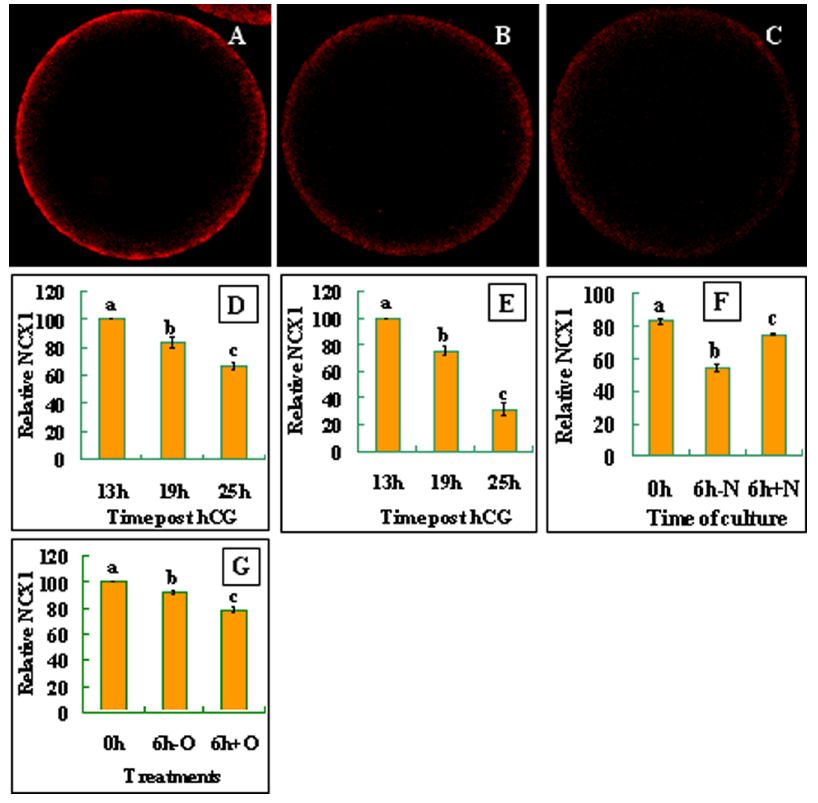
Figure 3. Distribution and quantification of NCX1 in mouse and rat oocytes. The micrographs are laser confocal images (equatorial sections) of oocytes with NCX1 pseudo-colored red. They show the cortical distribution of NCX1 in newly-ovulated mouse oocytes (A) or oocytes cultured for 6 h in CZB medium without (B) or with (C) H 2 O 2 addition. Graphs D and E show NCX1 quantification, respectively, in mouse and rat oocytes recovered at different times post hCG injection. Graph F shows NCX1 quantification after mouse oocytes recovered 19 h post hCG were cultured for 6 h with ( + N) or without (-N) 75 mM NaCl supplementation. Graph G shows NCX1 quantification in newly-ovulated mouse oocytes (0h), or oocytes cultured for 6 h in CZB medium with (6h + O) or without (6h-O) H 2 O 2 addition. Each treatment was repeated four times, with each replicate